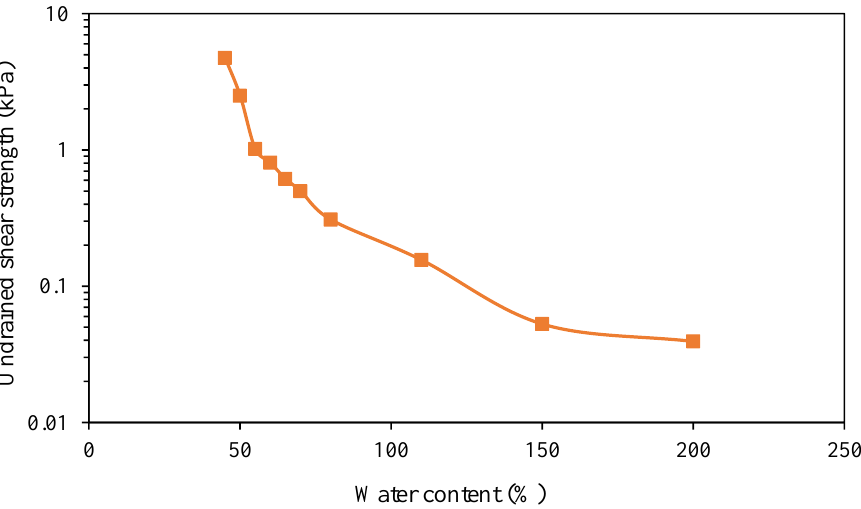
Figure 6. Reference undrained shear strength of HKMD with different water contents obtained from vane shear tests.